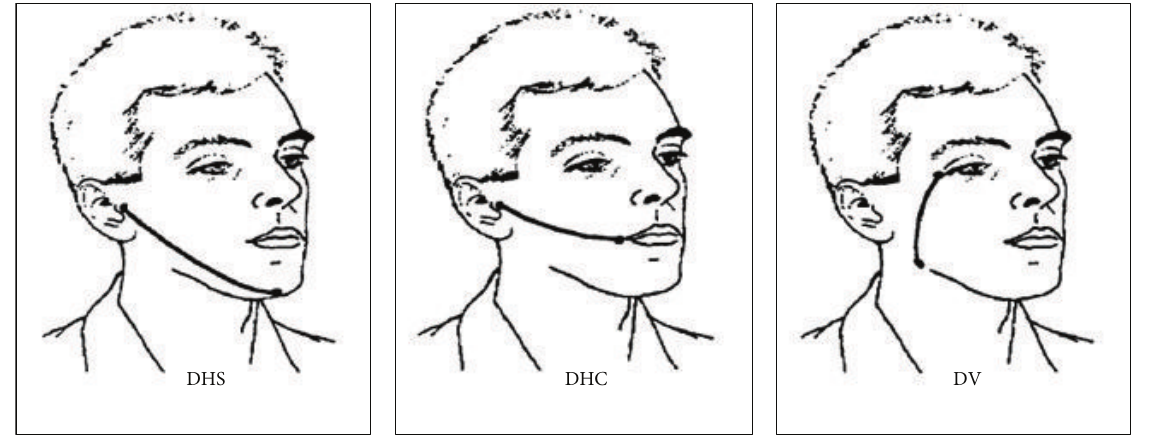
Figure 3: Distances used in the Laskin method to measure inflammation.